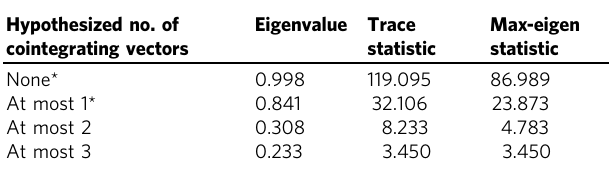
Table 4 Results of Johansen co-integration test.